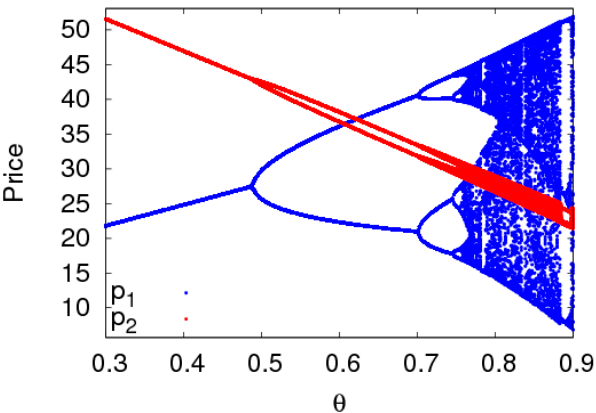
Figure 9. The bifurcation diagram of the dynamic system (6) with θ changing when a 1 = 0.012 and a 2 = 0.005 .